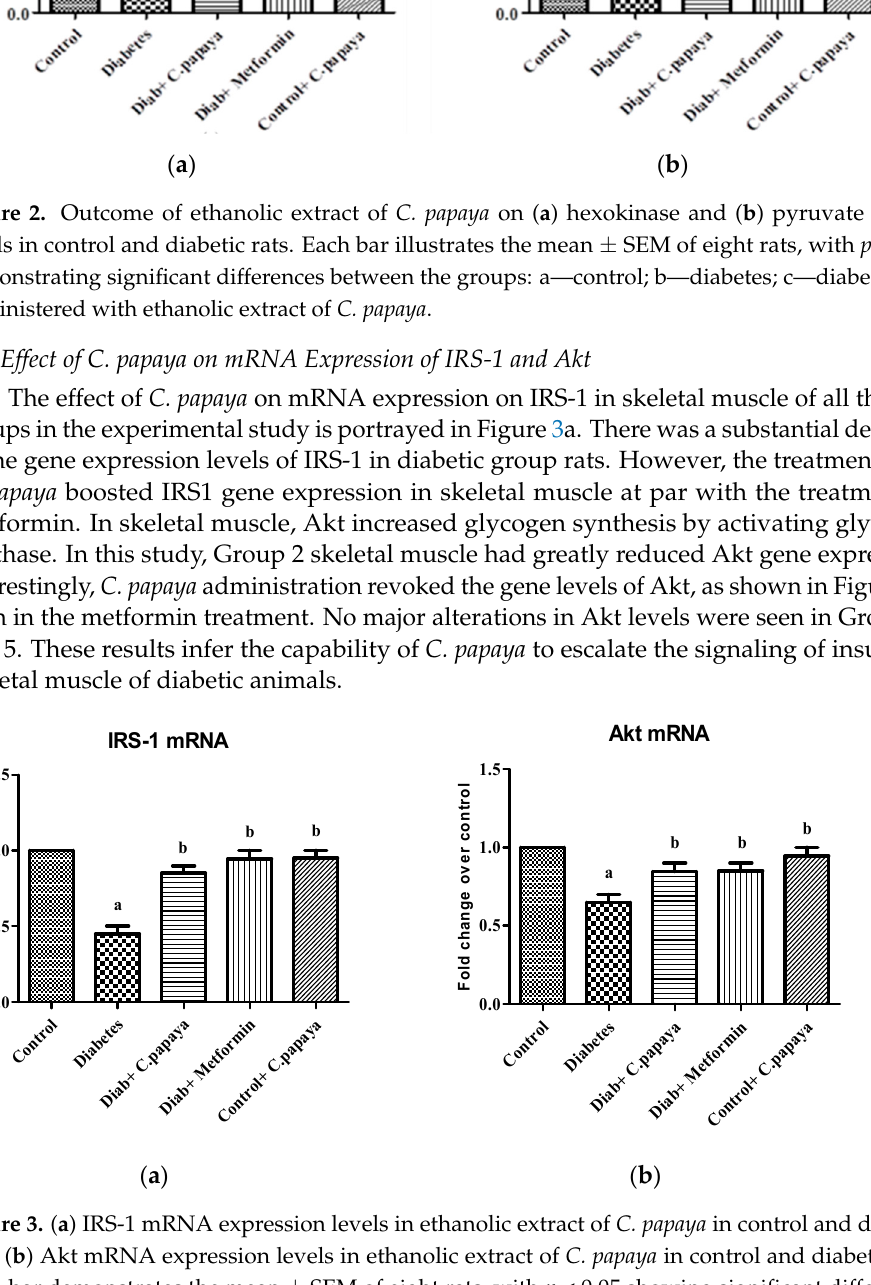
Figure 1. Outcome of ethanolic extract of C. papaya on ( a ) glucose-6-phosphatase and ( b ) fruc- tose-1,6 bisphosphatase levels in control and diabetic rats. Each bar illustrates the mean ± SEM of eight rats, with p < 0.05 demonstrating significant differences between the groups: a—control; b—diabetes; c—diabetic rats administered with ethanolic extract of C. papaya; d—diabetic rats treated with metformin.